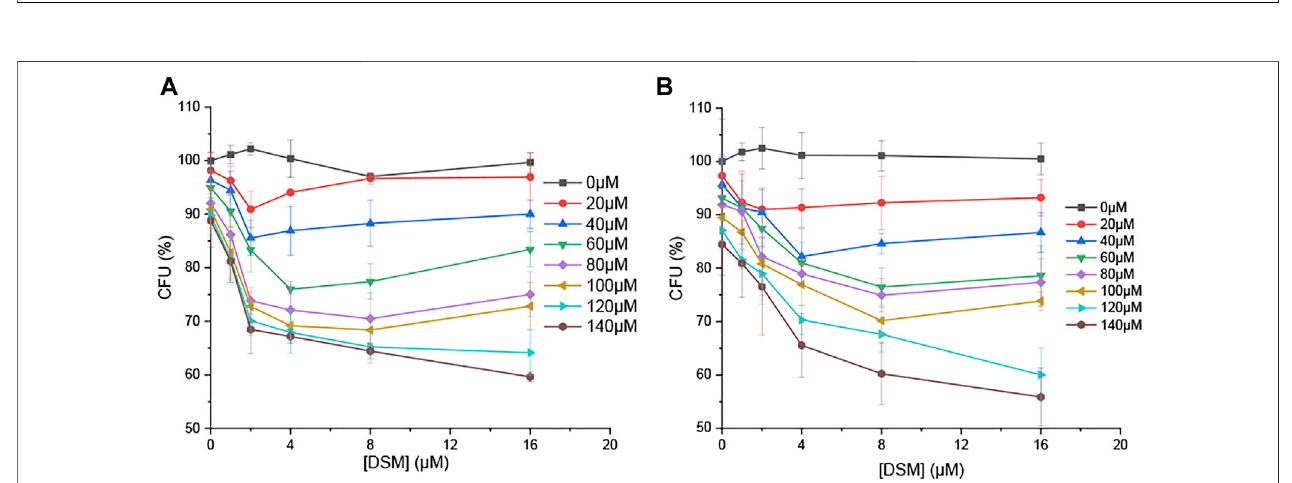
FIGURE8| CFUpercentage(%)ofbacteriainthepresenceof DSM (0,1,2,4,8,and16 µM)andClO − (0,20,40,60,80,100,120,and140 µM)toward (A) ESBL- EC and (B) MRSA.